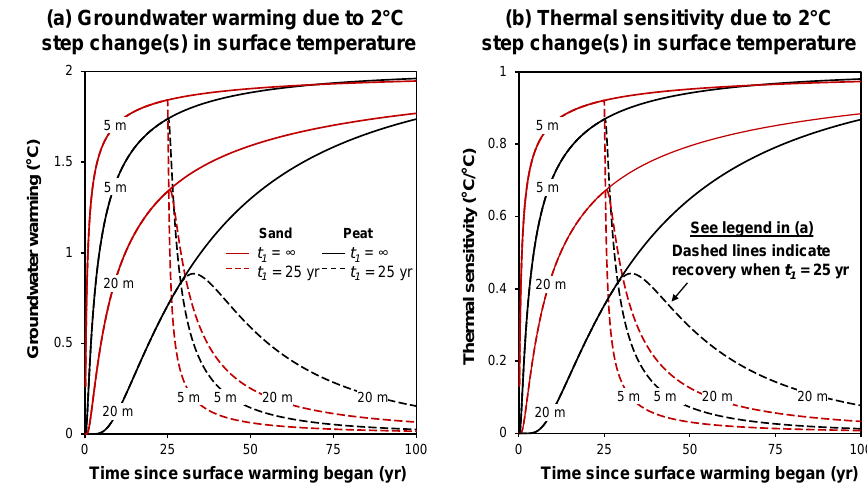
Figure 7. (a) Groundwater temperature warming due to a permanent (solid lines) or temporary (dashed lines) step increase in surface temperature vs. the time since the surface warming began. (b) Groundwater thermal sensitivity vs. time for each of the eight scenarios presented in (a) . The results shown in (a) were obtained with Eq. (11) driven with the step boundary condition (Eq. 10), with (cid:49)T = 2 ◦ C and t 1 = infinity (solid lines) or 25 years (dashed lines). The subsurface thermal properties were taken from the 50% saturated sand and peat values in Table 2, and the recharge rate was 20cmyr − 1 . The results shown in (b) were calculated with Eq. (17) using the same parameters as (a)